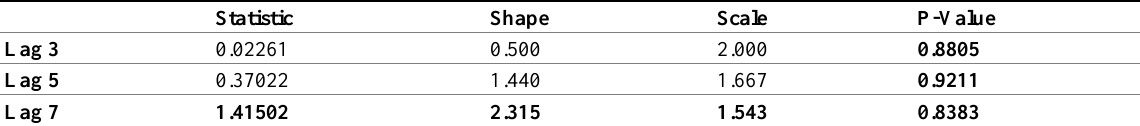
Table 5: ARCH-LM